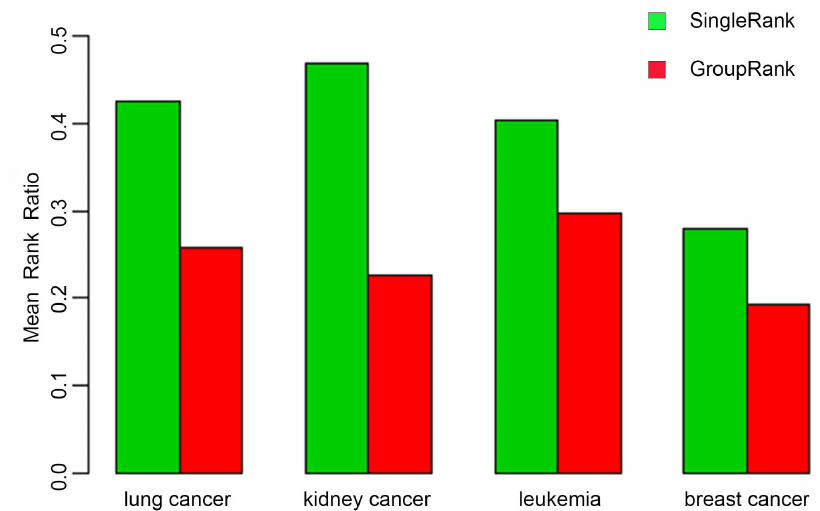
Figure 2. MRR comparisons of GroupRank and SingleRank. The colored bar chart shows the mean rank ratio (MRR) in disease gene ranking using GroupRank (red) and SingleRank (green). It indicates that GroupRank performs better with a lower MRR (p-value , 0.001).